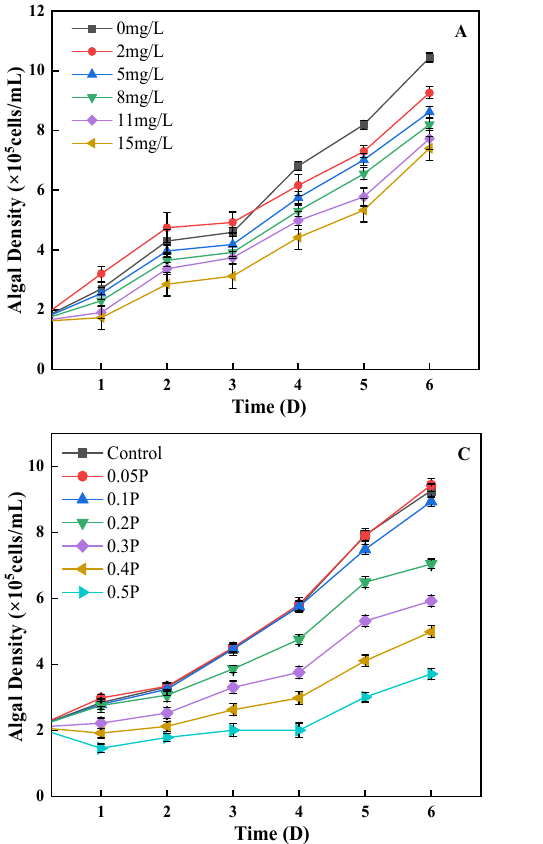
Figure 1. Effects of BPA, BPS, and BPA + BPS on the algal density of C. pyrenoidosa : ( A ) and ( B ) show the single effects of BPA and BPS on the algal density; ( C ) shows the effects of joint BPA and BPS toxicity on the algal density.